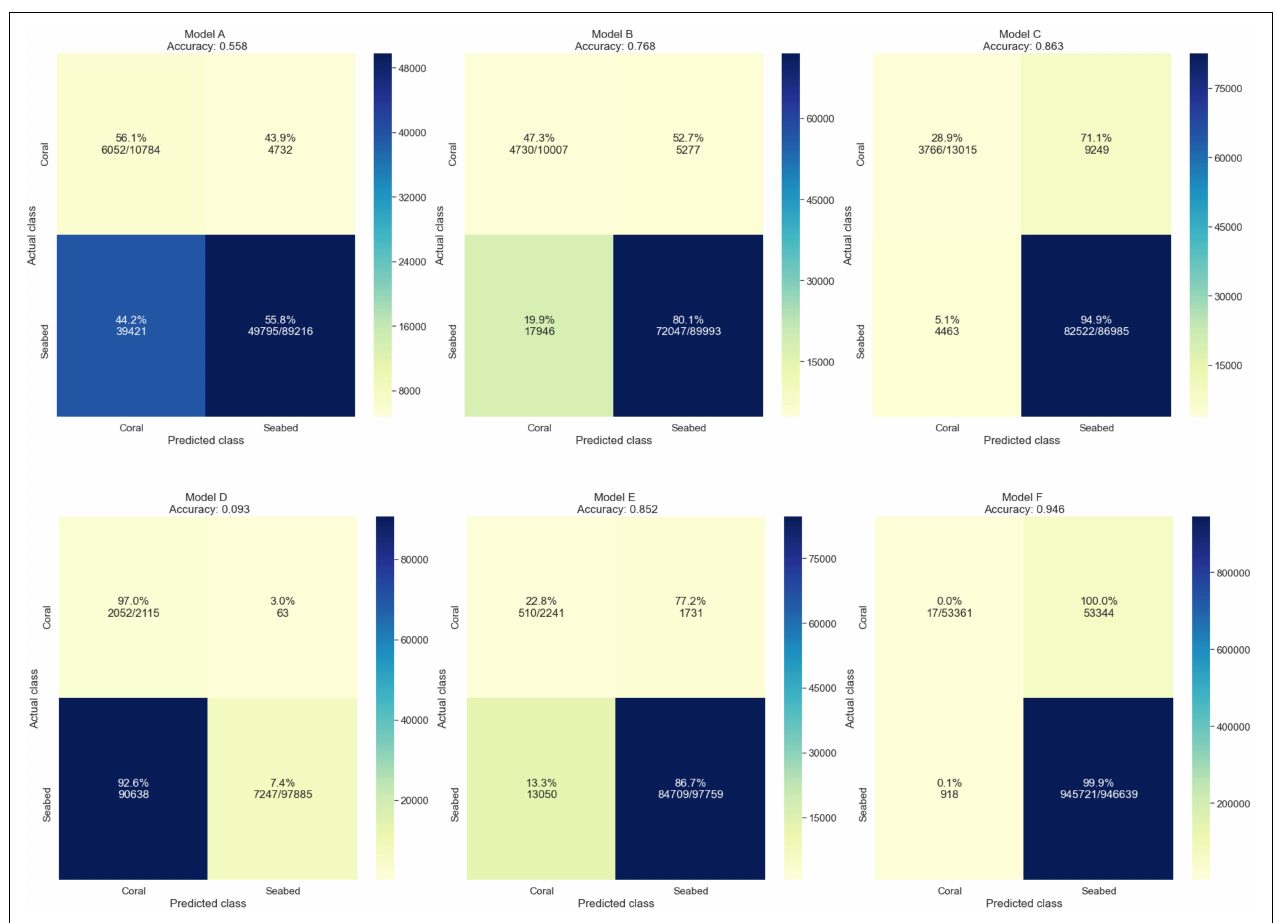
FIGURE 8 | Confusion matrices representing the CGC classification results for each dense cloud reconstruction. The “Actual class” on the y -axis refers to the manually annotated data, whereas the “Predicted class” on the x -axis relates to the classification output. The main diagonal of the matrices lists the correctly classified percentage of points per class. The colour scale bar on the right of each confusion matrix represents the number of points.